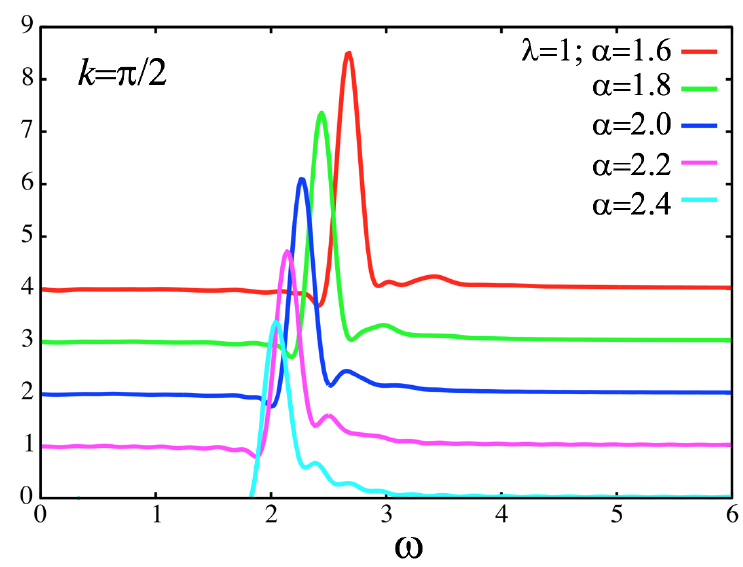
Figure 3: Spin dynamic structure factor across k = π/ 2 cuts for λ = 1 and different values of α . The emergence of a sharp isolated peak leaking out of the continuum is clearly observed as α decreases and long range order is developed. The curves are shifted for clarity. Negative values are artifacts of the Fourier transform, as described in the text. The finite width of the peaks is determined by the maximum simulation